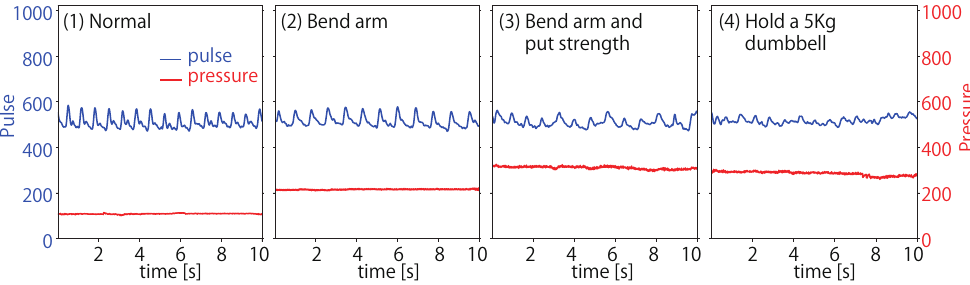
Figure 4. PPG data and pressure data collected in four